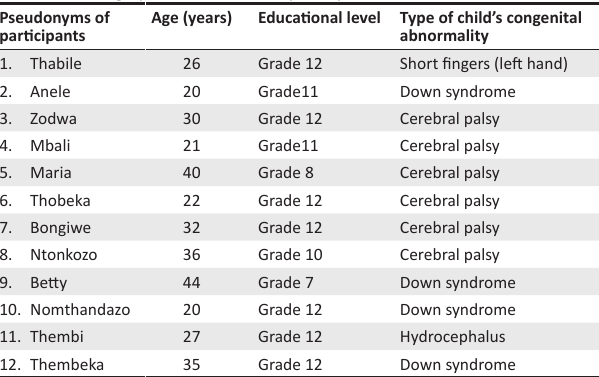
TABLE 1: Demographic information of participants. Pseudonyms of